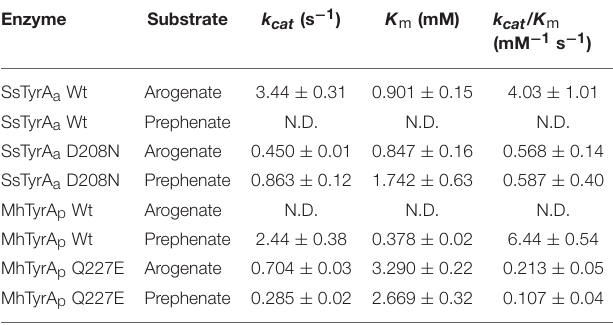
TABLE 1 | Kinetic analysis of MhTyrA p and SsTyrA a Wt and mutant enzymes.